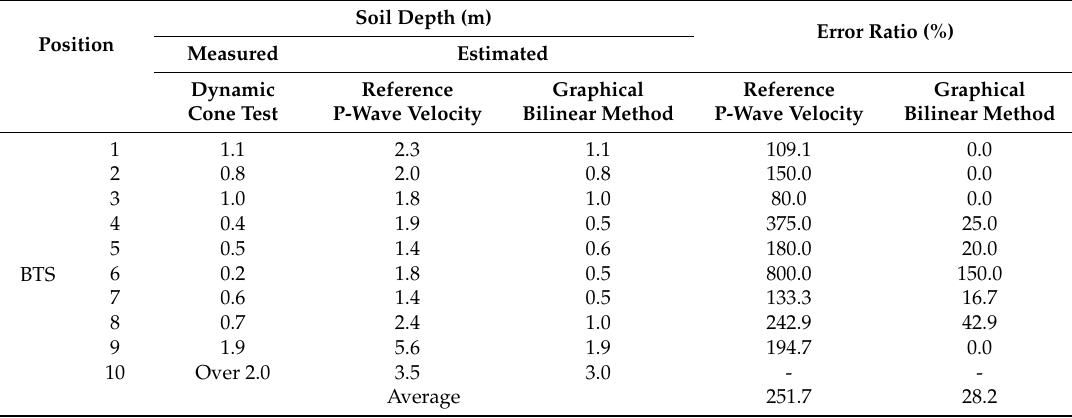
Figure 6. Measured DPI values of each stream: ( a ) BTS; ( b ) BS; ( c ) MS; and ( d ) TS. Note the numbers in each figure indicate the location of dynamic cone penetration test described in Figure 3. Table 1. Comparison between Measured and Estimated Soil